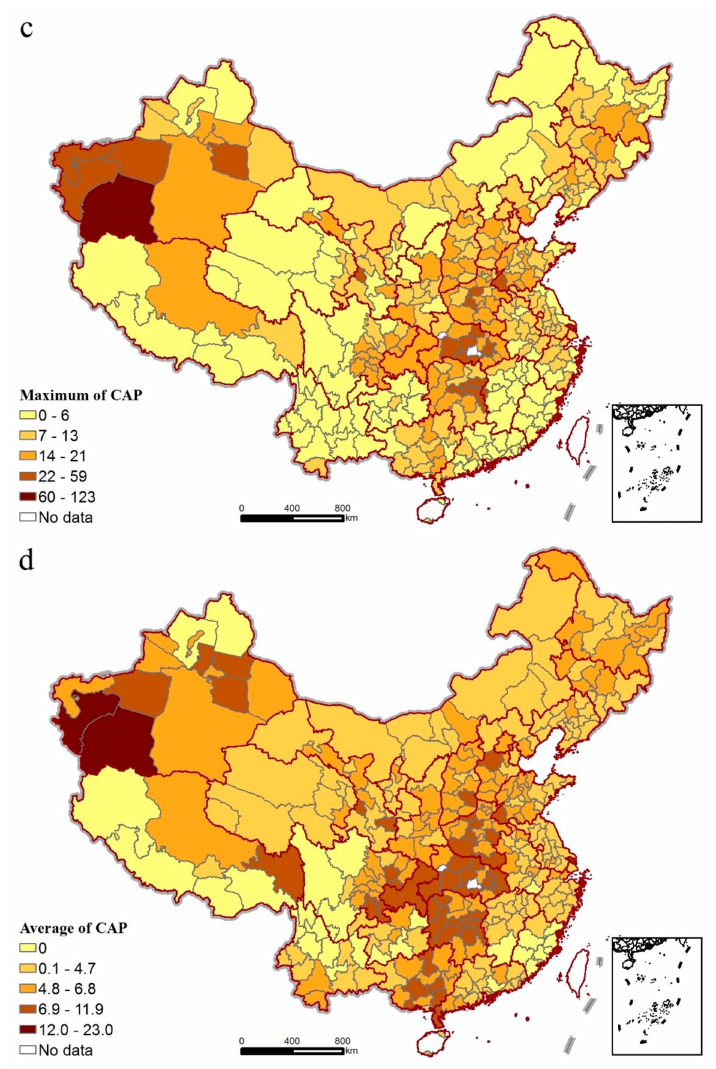
Figure 3. Spatial variations of continuous air pollution (CAP) in China. ( a ) CAP ratio ( b ) Times of CAP ( c ) Maximum of CAP ( d ) Average of